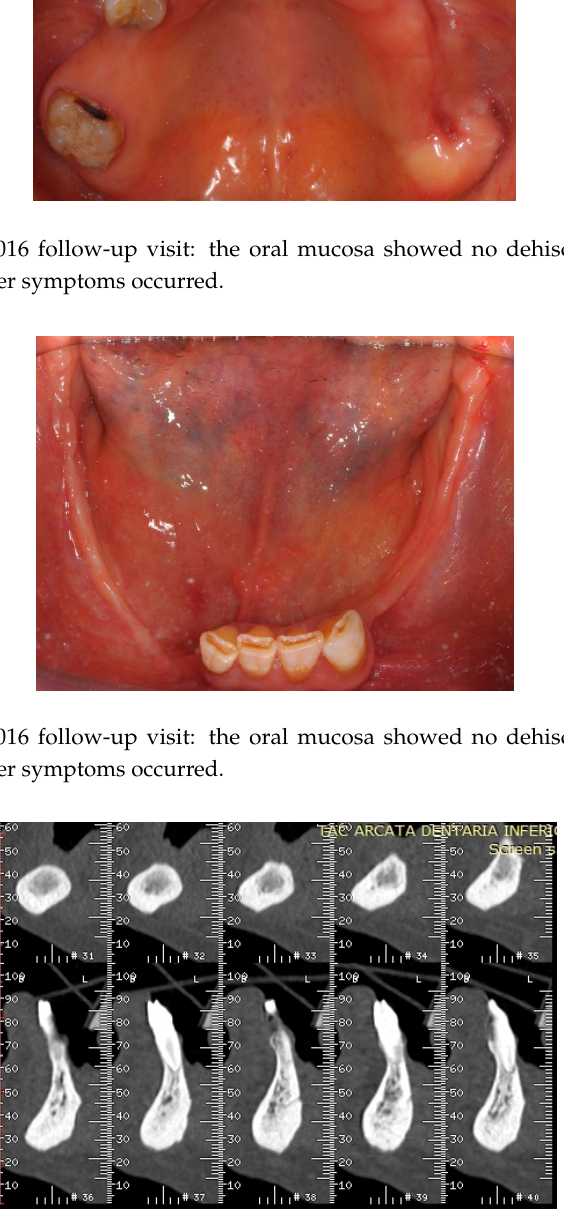
Figure 12. CT scan dated October 2016 showed no erosion of the mandibular buccal and lingual cortical bone.